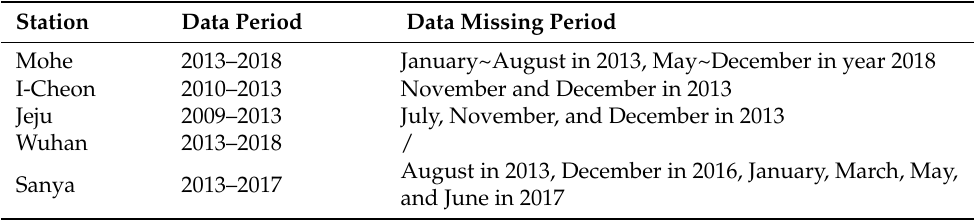
Table 2. Data availability of the selected ionosonde stations during the period of 2009–2018.